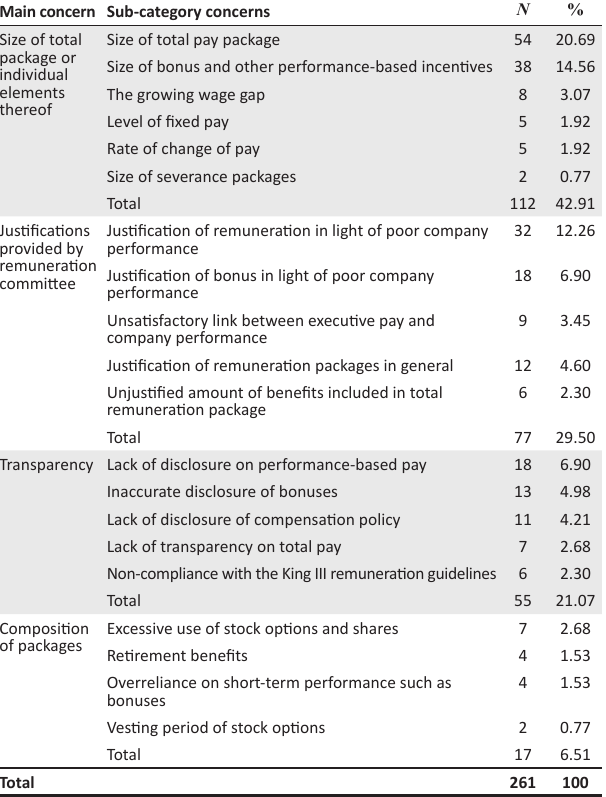
TABLE 2: Categories summarising challengers’ executive remuneration-related concerns. Main concern Sub-category